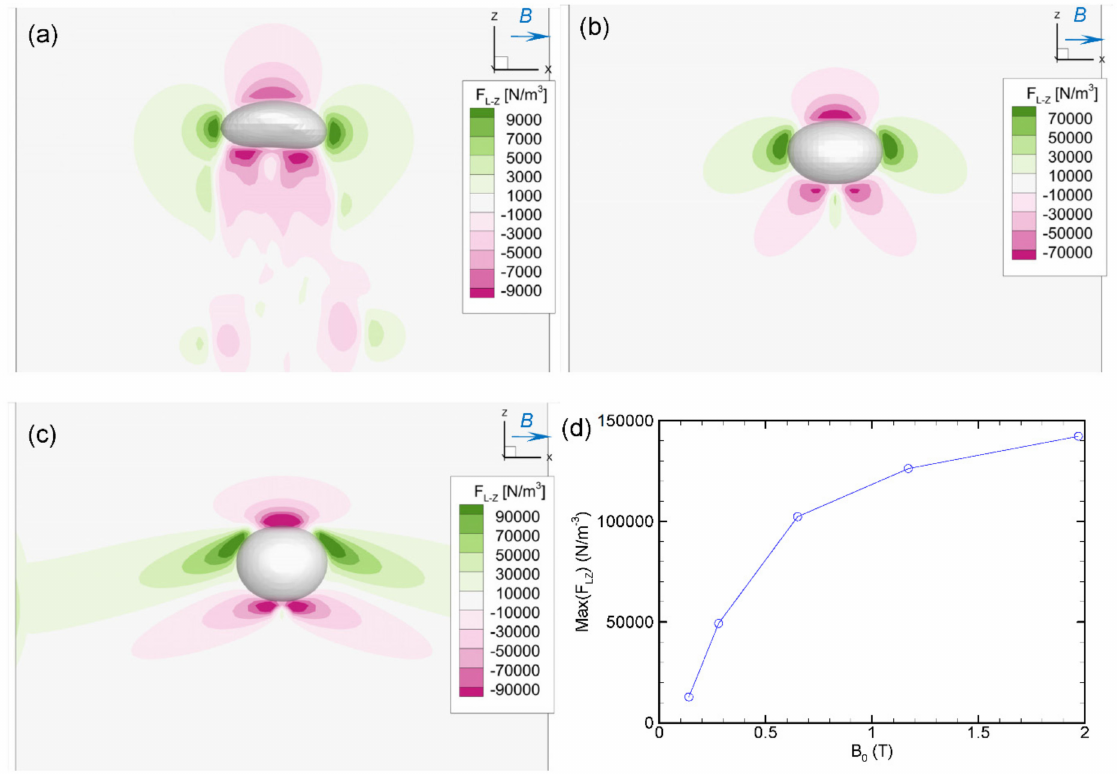
Figure 25. Distribution of Lorentz force in the y = 0 plane for ( a ) B 0 = 0.14 T, ( b ) B 0 = 0.56 T, ( c ) B 0 = 1.12 T and ( d ) the maximum value of the z -component of the Lorentz force in the y = 0 plane. The Lorentz force vectors are not depicted in ( a – c ) since the x-component of the vector is zero, as shown in Figure 23b.